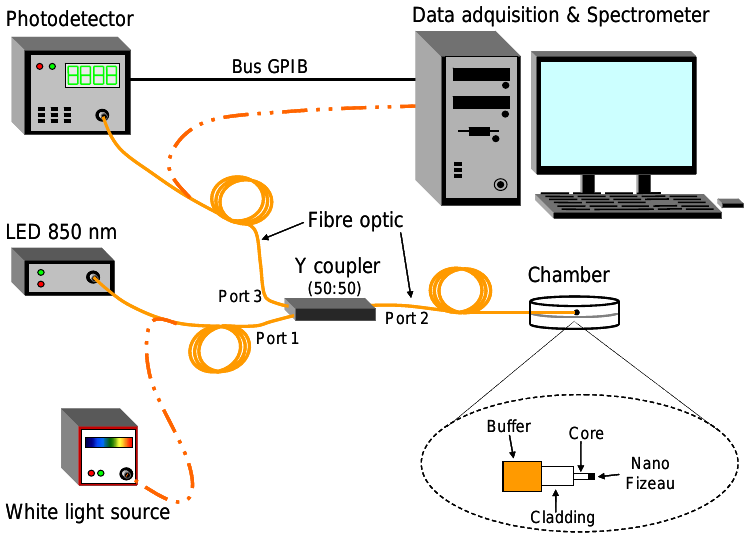
Figure 1. Experimental set-up arranged in order to register the nanocavity construction and the variation in the reflected optical power when exposed to VOCs (fiber optic solid line), and to record the absorbance spectra (fiber optic dotted